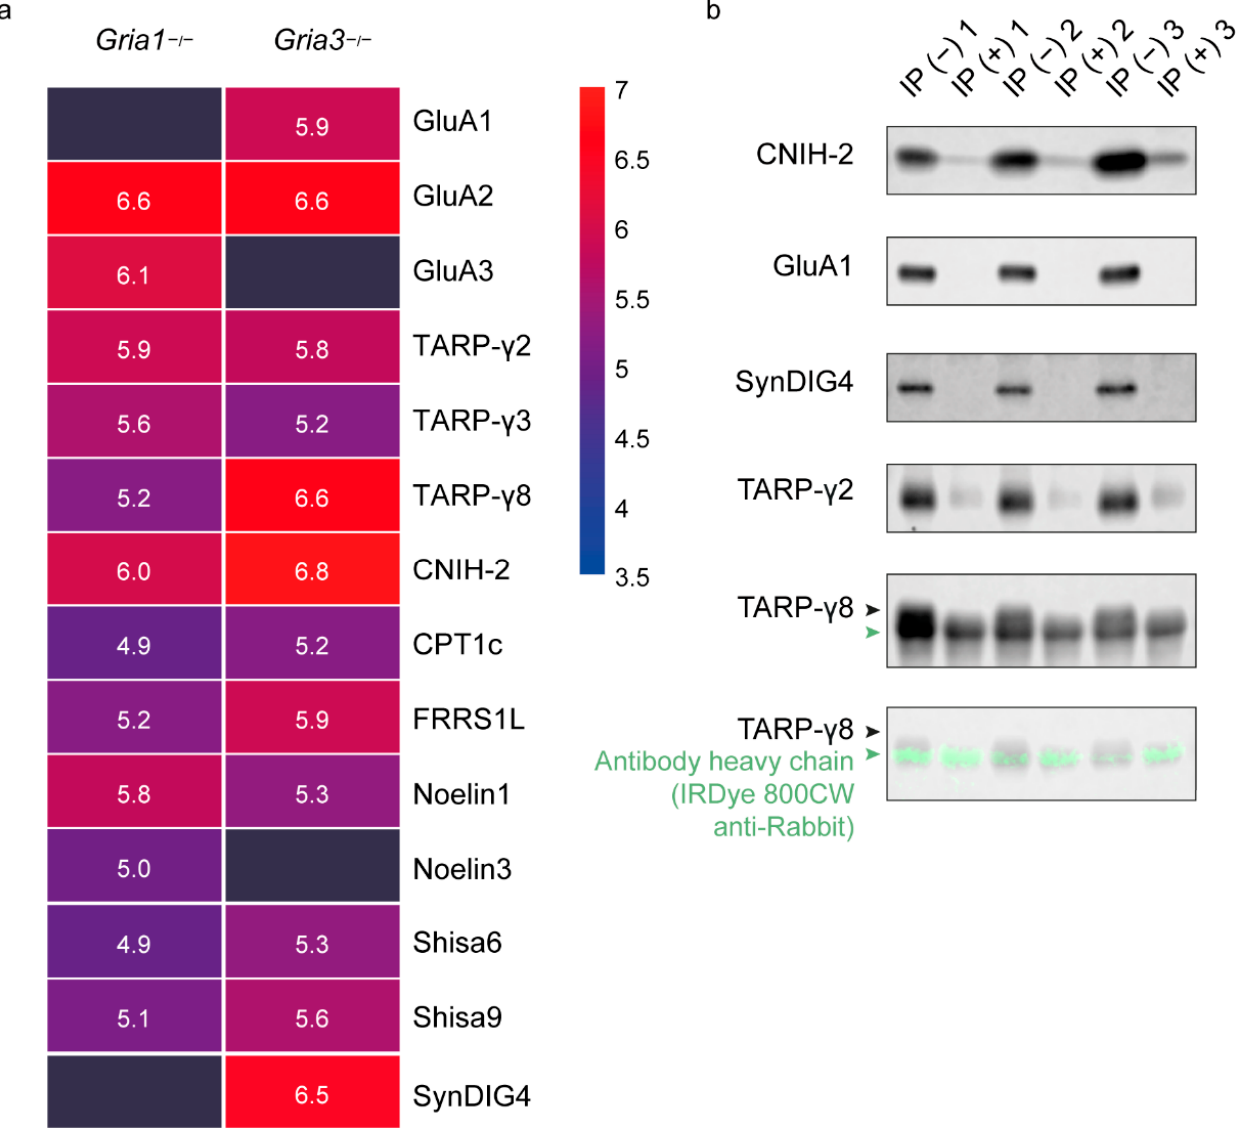
Figure 2. Differential GluA1/2 and GluA2/3 AMPAR interactomes. ( a ) Immuno-purification-mass spectrometry (IP-MS) using anti-GluA2/3 in Gria1 - and Gria3 KO hippocampus (n = 3 Gria1 KOs, and n = 4 Gria3 KOs). Protein abundances of AMPAR subunits and known interactors are shown as mean log 10 iBAQ intensity values, and color coded from high abundance (red) to low abundance (blue). ( b ) Validation of Gria1 KO IP-MS, using anti-GluA2/3 on GluA1-depleted wildtype hippocampus followed by immunoblotting (n = 3/condition). IP − IP without prior depletion of GluA1; IP+: IP with prior depletion of GluA1. The antibody heavy chain of anti-GluA2/3 is visualized in green with IRDye 800CW anti-Rabbit below TARP- γ 8, which is visualized with a mouse antibody.